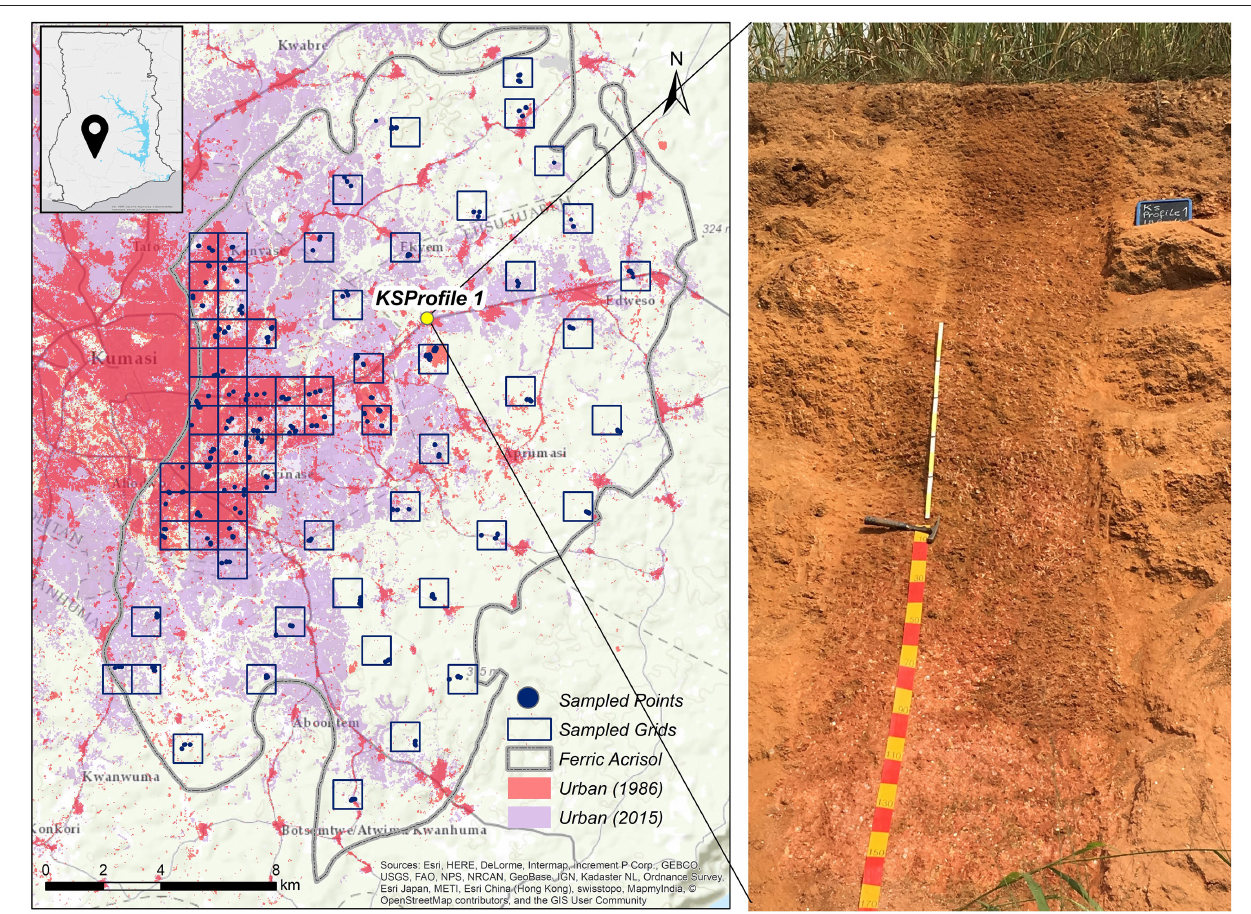
FIGURE 1 | Kumasi agglomeration built-up area in 1986 showing the stratified grid-based sampling locations of the Ferric Acrisols. Sampling grids (1 × 1km) closer to the core of the city that were already urban in 1986, were denoted as long-term urban soils ( ≥ 30 years with respect to the sampling year 2016), and those located in the periphery that were not yet urban in 1986, were denoted short-term urban soils. Three fields per grid were sampled, whereby three replicates per field were